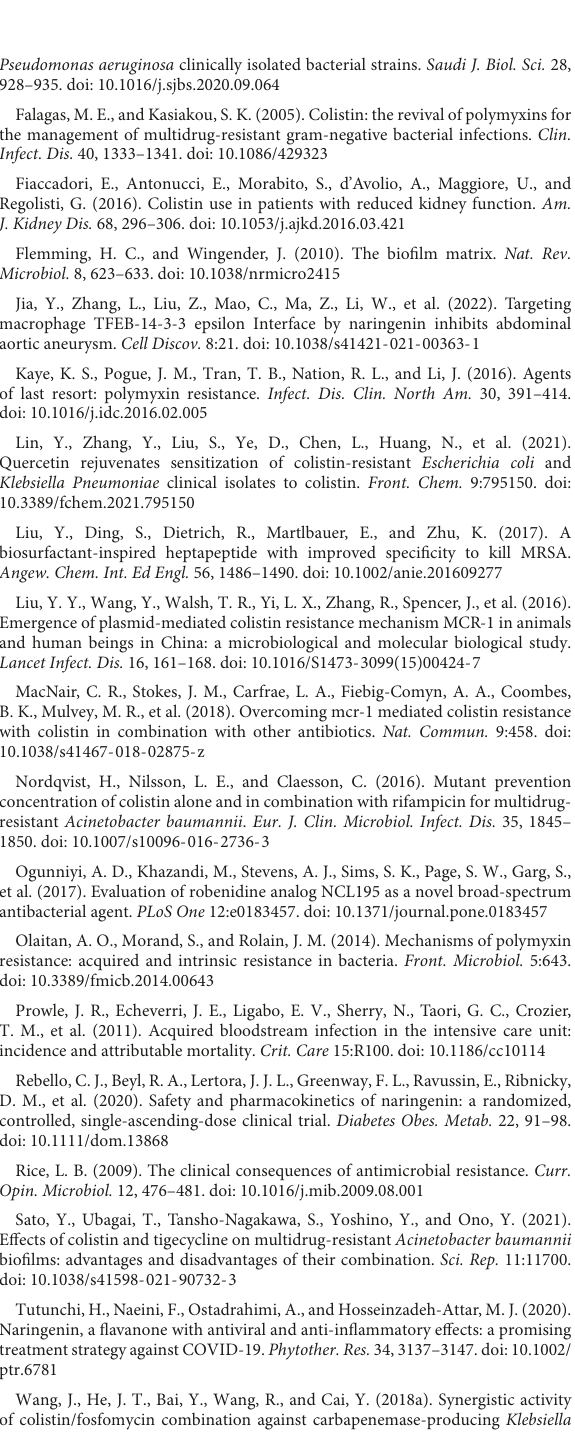
SUPPLEMENTARYFIGURE1 Checkerboard analysis of the synergistic antibacterial activity of the combination of colistin and naringenin against colistin-resistant Klebsiella pneumonia , colistin-resistant Escherichia coli , and